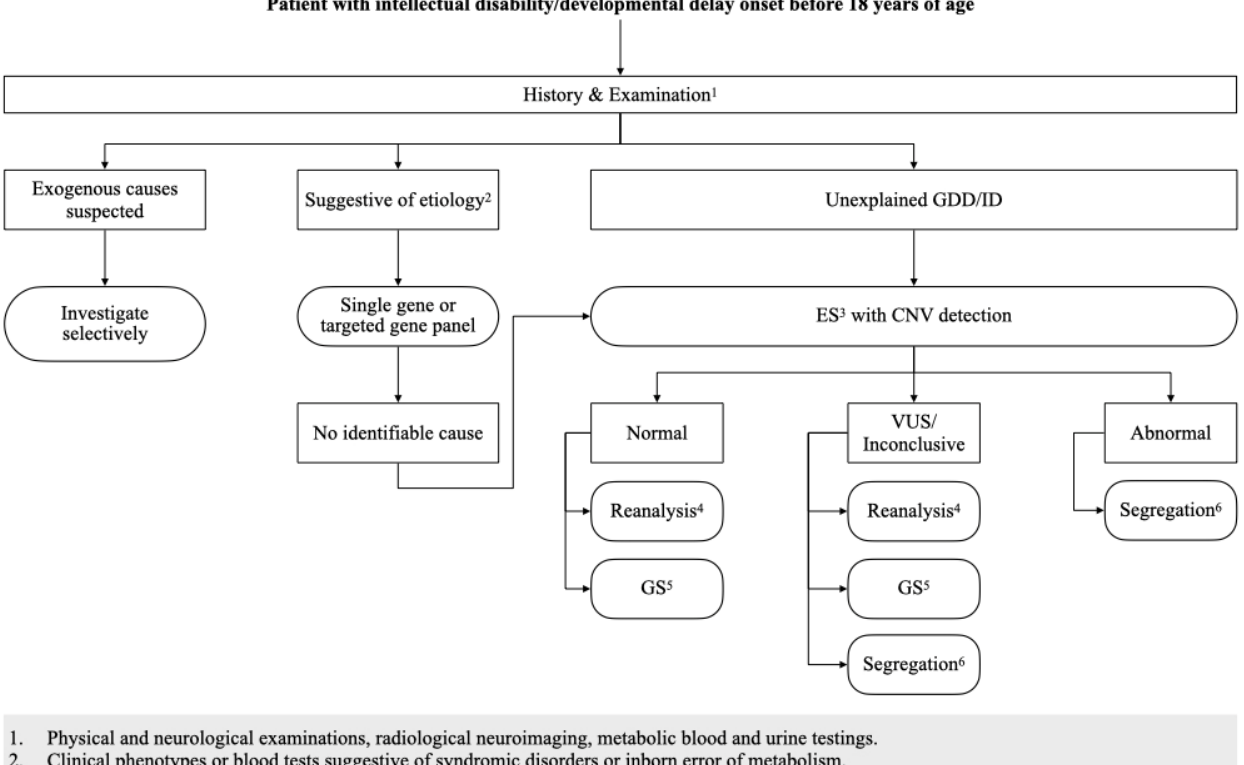
Figure 1. Proposed diagnostic algorithm for evaluation of unexplained GDD/ID. Abbreviations: CNV = copy number variants; DD = developmental delay; ES = exome sequencing; GS = genome sequencing; ID = intellectual disability; VUS = variants of unknown significance.